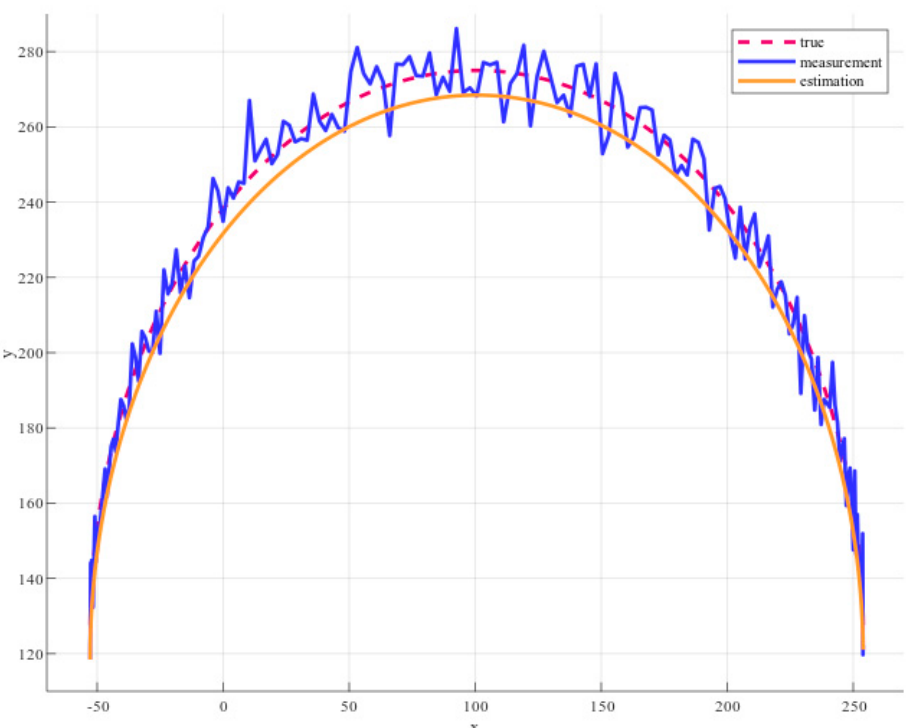
Figure 25. The simulation result of predicting ‘ x c ’, ‘ y c ’ and ‘ r ’ parameters from the circle detection.